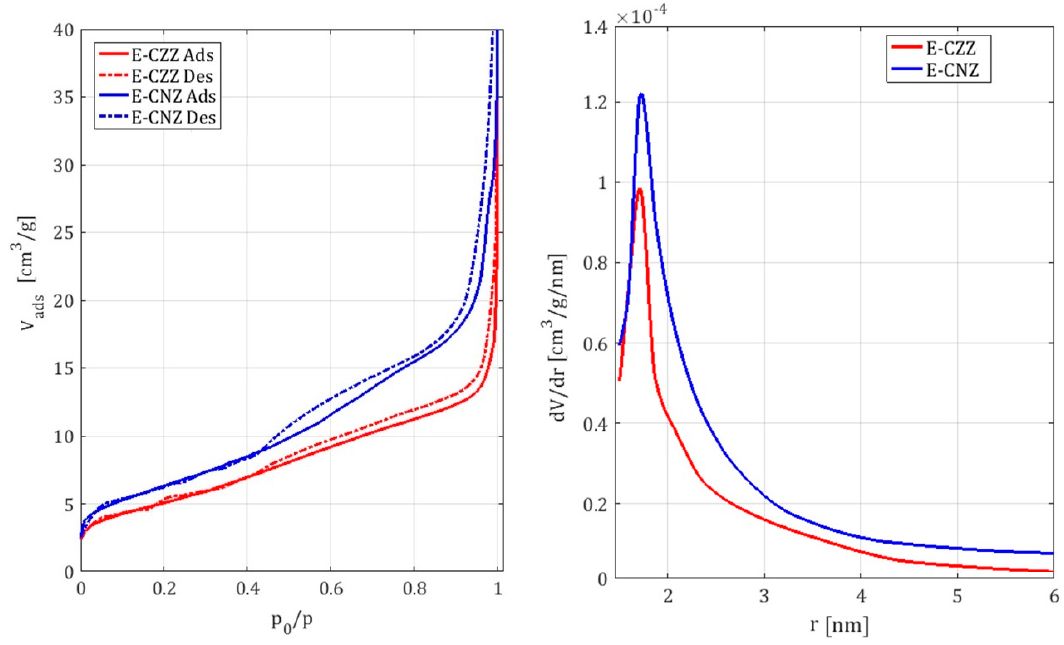
Figure 2. Comparison of the sorption isotherms ( left ) and the pore radius distribution ( right ) of the samples containing ZnO (E-CZZ) and NiO (E-CNZ).